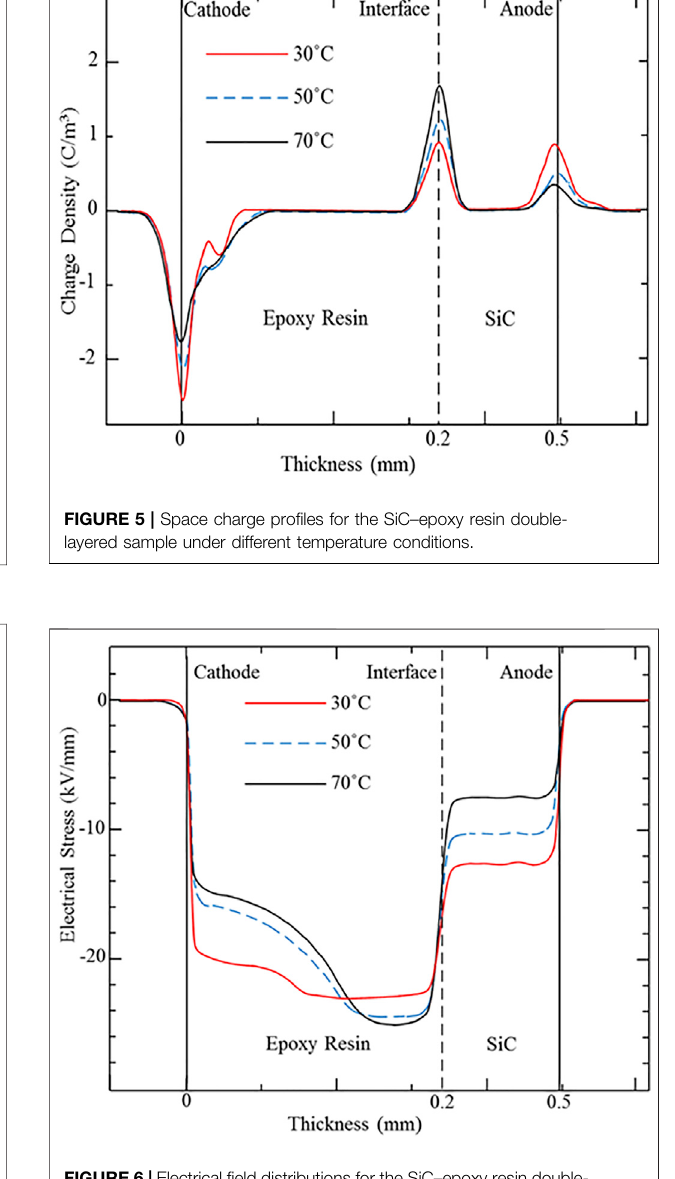
FIGURE 6 | Electrical fi eld distributions for the SiC – epoxy resin double- layered sample under different temperature